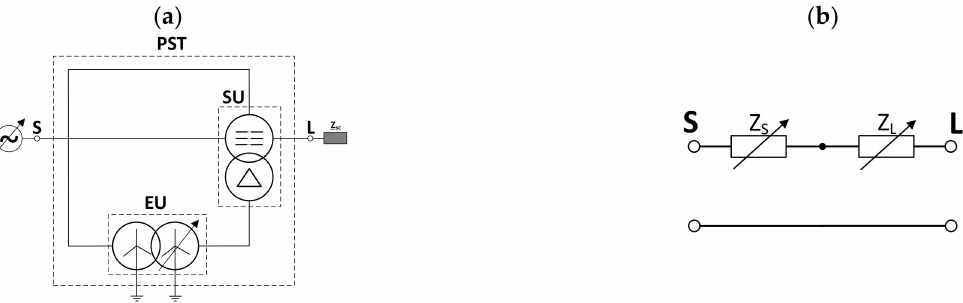
Figure 13. ( a ) General view of PST under short circuit test procedure and their ( b ) equivalent simplified